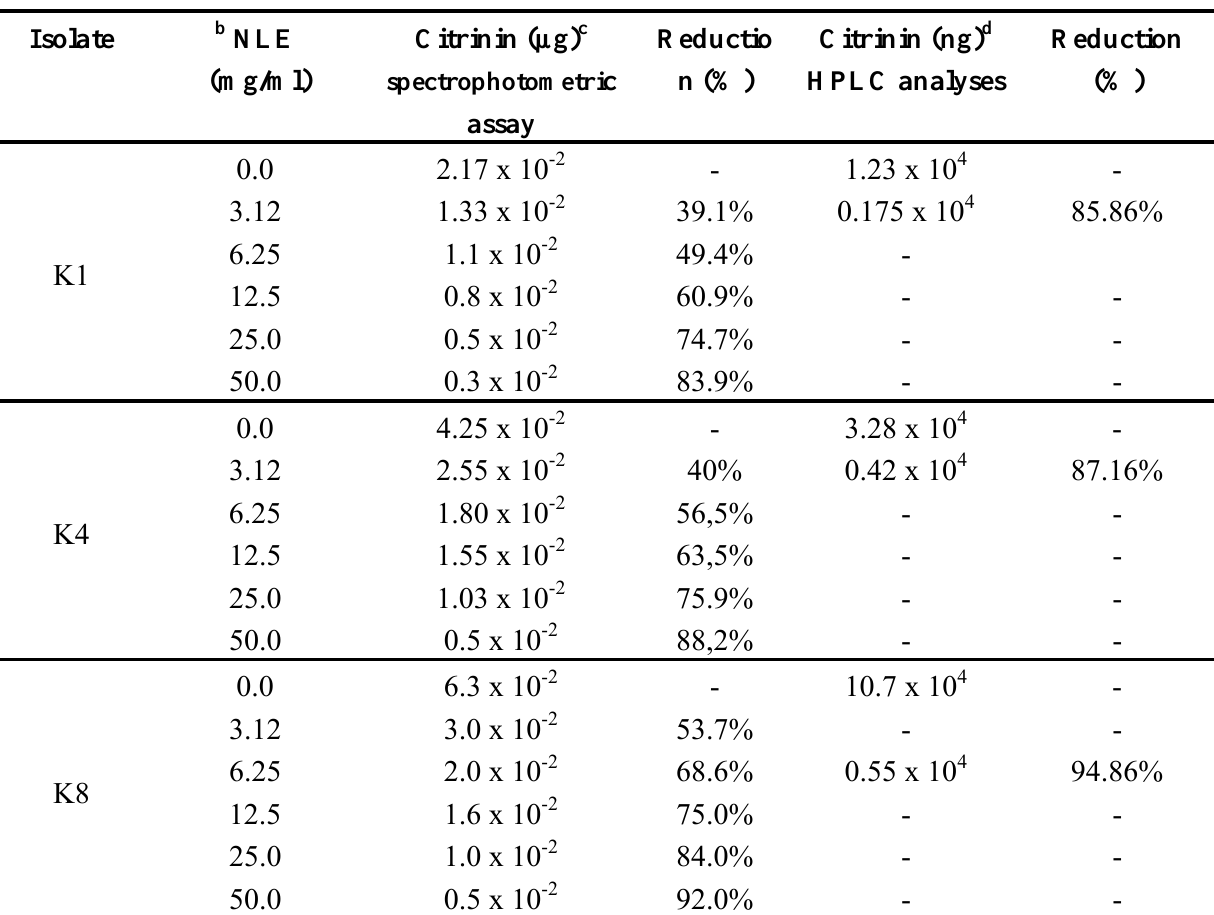
Table 1. Effect of NLE (mg/ml) on citrinin production (ng/ml) by Penicillium citrinum a (isolates K1, K4 and